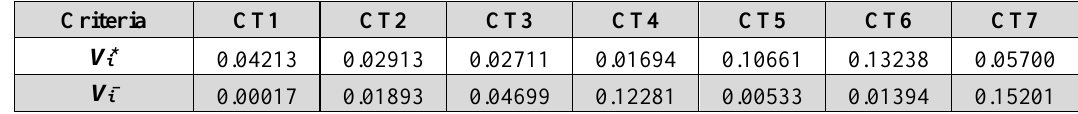
Table 11. Best value V i* and worst value V i-